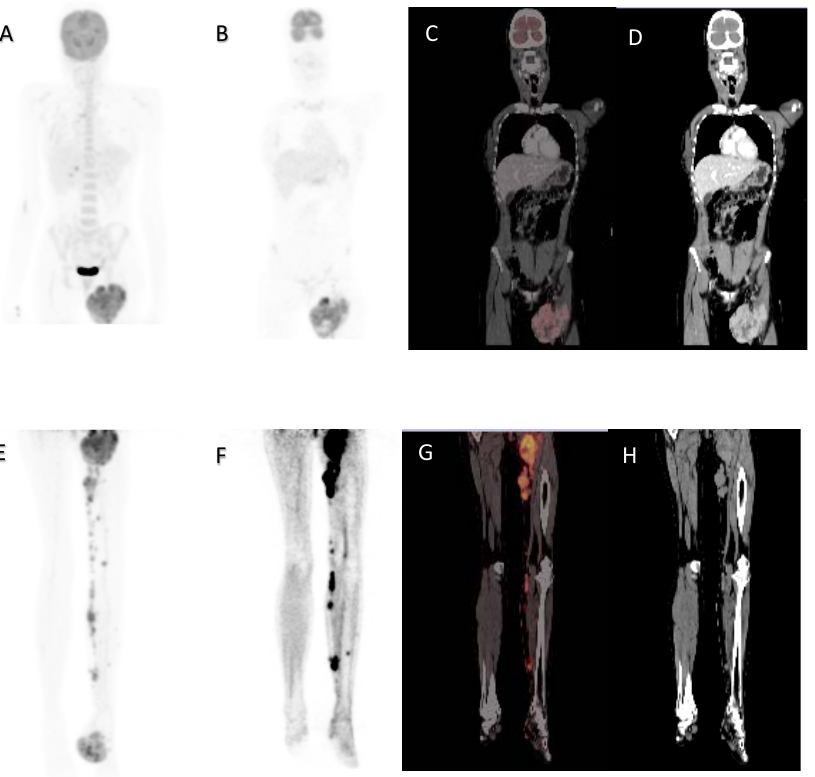
Figure 4. A 32-year-old female, acral lentiginous melanoma resected from the left foot, presented with a recurrence and nodal metastases. Maximal intensity projection image ( A ), coronal 18 F-FDG PET ( B ), fused ( C ) and CT ( D ) images demonstrating large inguinal node metastases. Maximal intensity projection image ( E ), Coronal 18 F-FDG PET of lower limbs ( F ), fused ( G ) and CT ( H ) images demonstrating left foot primary with subcutaneous and nodal metastases in the left leg. MTV 126.73 cm 3 , TLG 567.75, SUVmax 10.78, whole-body MTV 635.48 cm 3 and whole-body TLG 9964.33. Overall survival was 8 months.